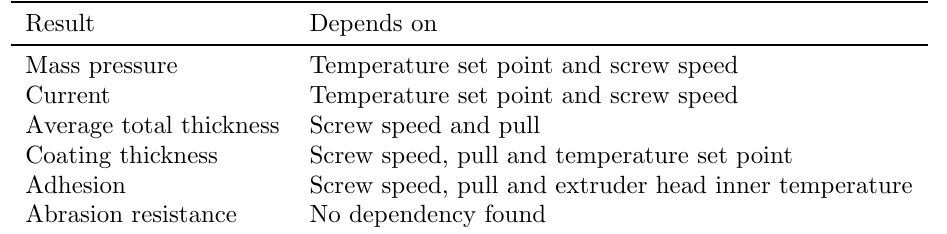
Table 2: Model results